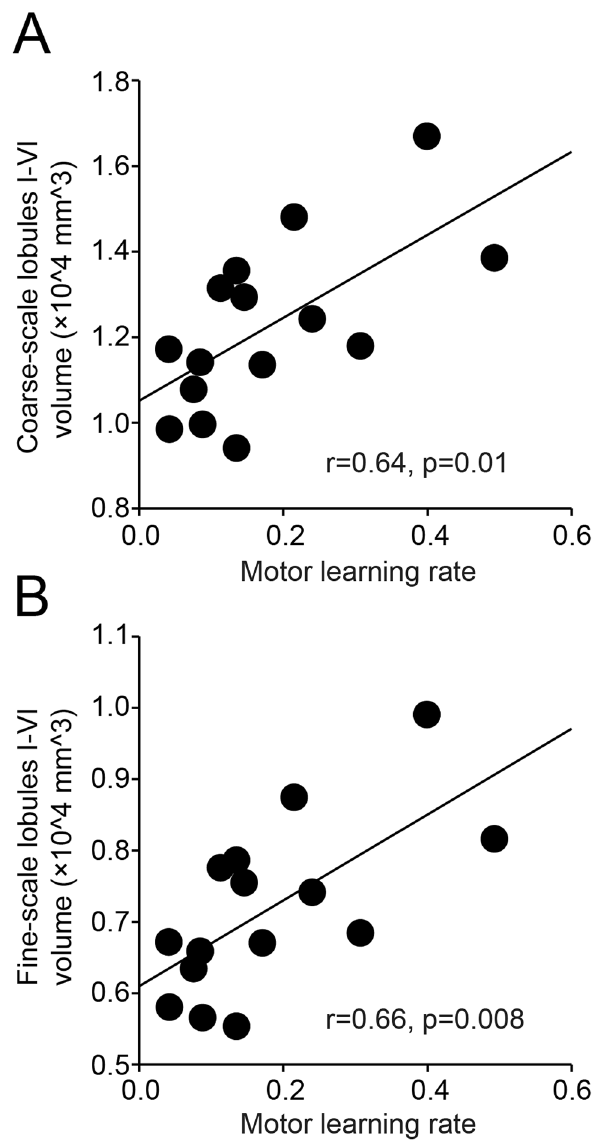
Figure 6. Cerebellar changes and motor learning rates. ( A , B ) Graphs show a correlation between motor learning rates and the volume of coarse- and fine-scale sensorimotor cerebellar lobules I–VI in SCI subjects (SCI = 15). Note that SCI subjects with slower motor adaptation learning rates were those with smaller volume of coarse- and fine-scale sensorimotor cerebellar lobules I–VI. Error bars indicate SDs. *p <